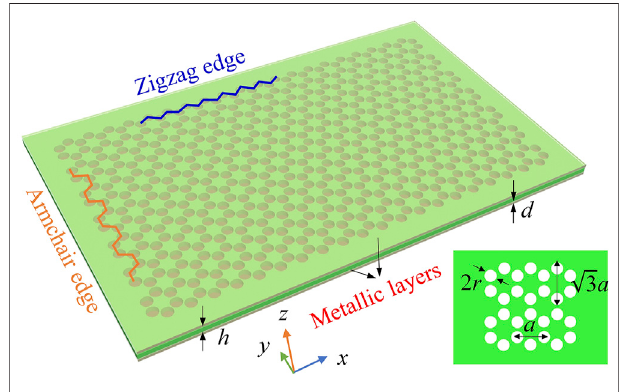
FIGURE 1 | Oblique-view of a rectangular air-hole honeycomb gyromagnetic photonic crystal. There exist two zigzag edges (blue) and two armchair edges (orange) along the x and y directions, respectively. The lattice constant along the zigzag edge is a , but that along the armchair edge is (cid:1)(cid:1) √ 3 a .Thethickness ofthisair-hole GPCis h (cid:1) 0.1 a (cid:1) 0.3 cm,and theradiusof air-hole is r (cid:1) 0.8 cm. The lower right panel is a partial schematic